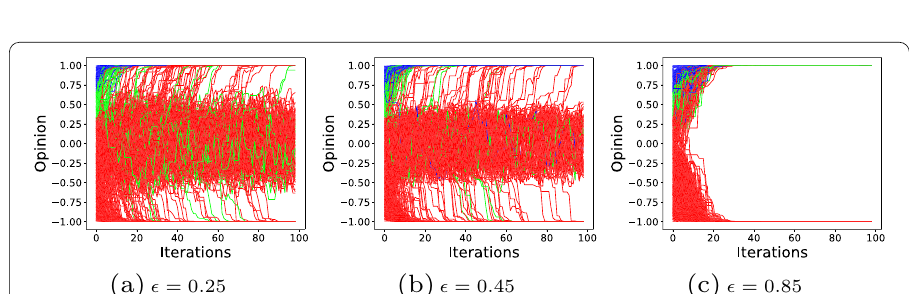
Fig. 5 Opinion evolution varying ǫ for ARWHK . Low values of ǫ will favor the application of RWHK model— thus leading to higher fragmentation—while high values will favor the application of AWHK model—thus leading to convergence